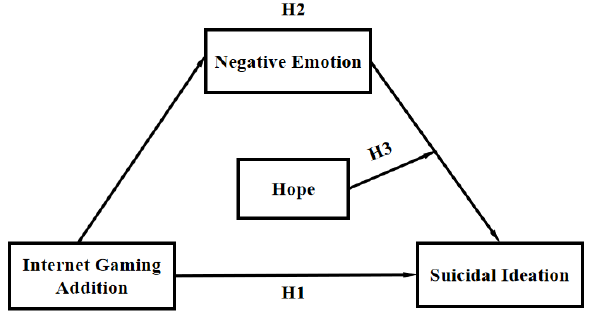
Figure 1. The conceptual model.